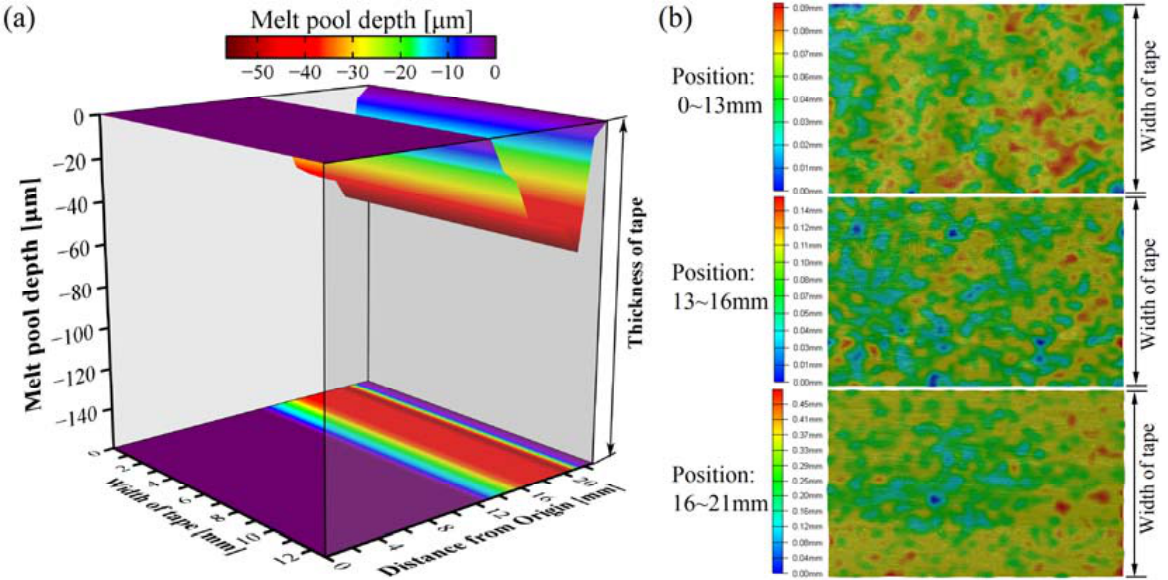
Figure 12. Melt pool depth approximation ( a ) and surface morphology ( b ) after laser